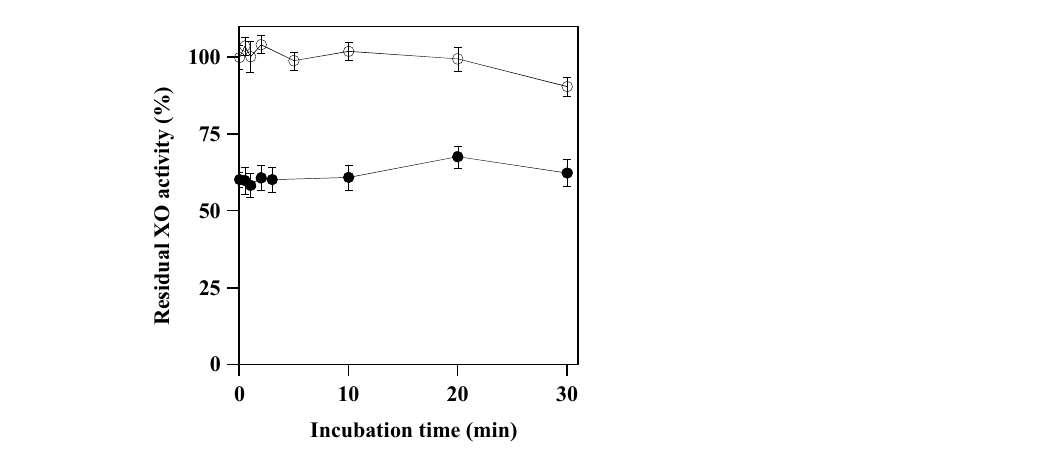
Figure 3. Reversibility of the inhibition by ALS-28 in xanthine oxidase samples incubated at 25 ◦ C. A sample of XO (0.136 U/L in buffer A) was incubated at 25 ◦ C in the absence (open circles) or presence of 60 µM ALS-28 (filled circles). At the indicated times, 125 µL aliquots were withdrawn and then immediately assayed for XO activity after the addition of 375 µL of 100 µM xanthine in buffer A. The residual XO activity was expressed as a percentage of that measured in the absence of inhibitor at time zero. Values were reported as the mean ± SE. Other details are described in Materials and Methods.